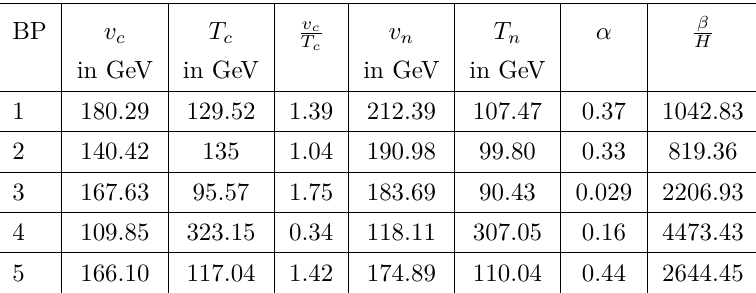
Table 4. The values of the parameters related to the phase transition properties used for the estimation of the GW intensity from strong first-order phase transition for the chosen five BPs (BP 1–5). See the text for details.